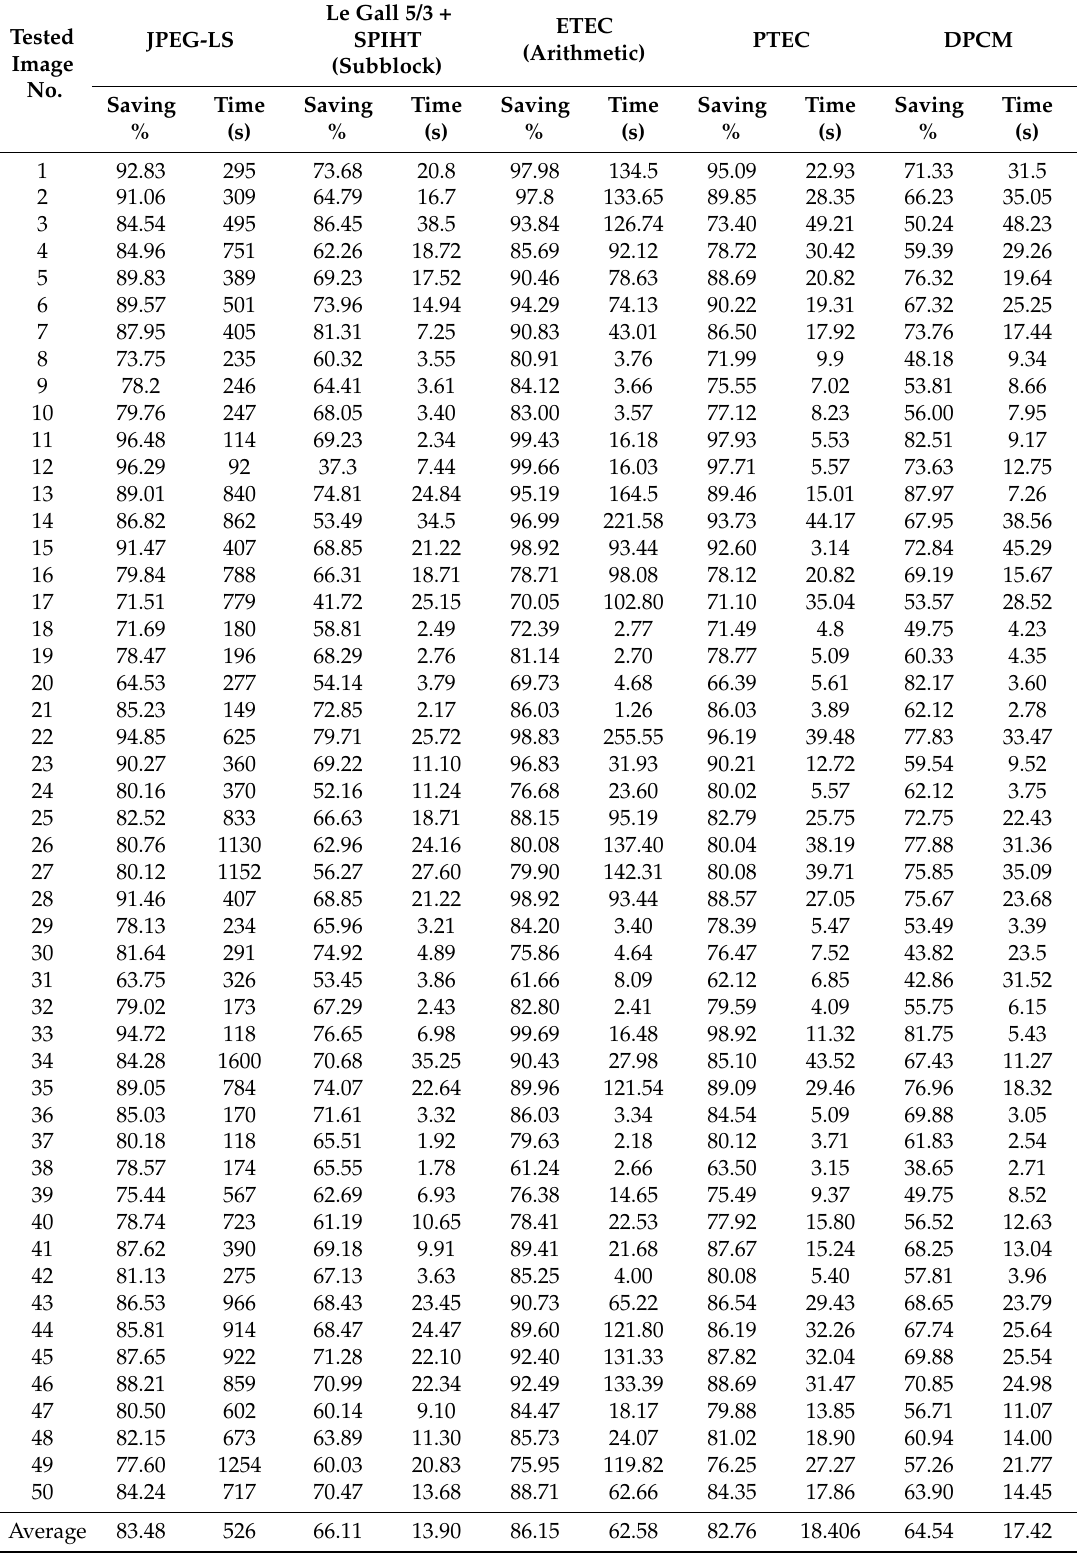
Table 3. Comparison of percentage saving and computation time for pixelated